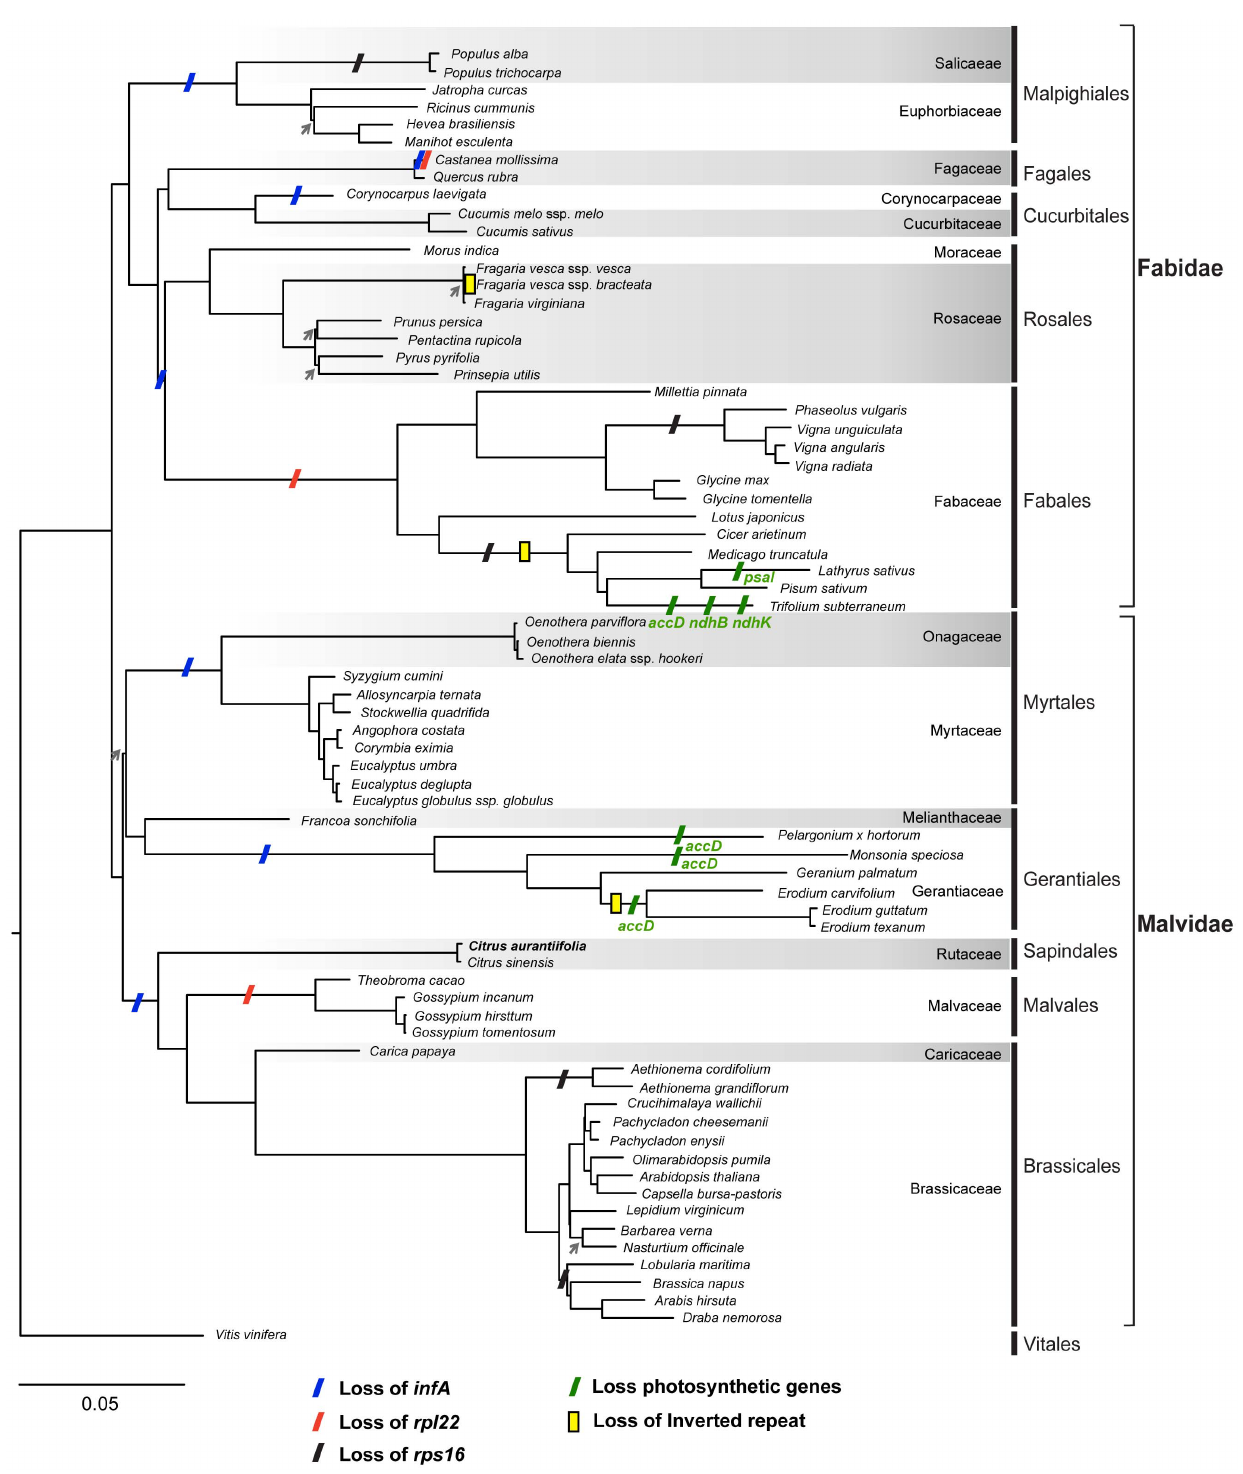
Figure 2. Maximum likelihood phylogeny of the representative rosids lineages. The common grape vine ( Vitis vinifera ) is included as the outgroup to root the tree. The concatenated alignment includes 62 conserved chloroplast genome genes and 54,689 aligned nucleotide sites. Nodes received , 70% bootstrap support are indicated by gray arrows. The putative events of gene losses are inferred based on the most parsimonious scenario.